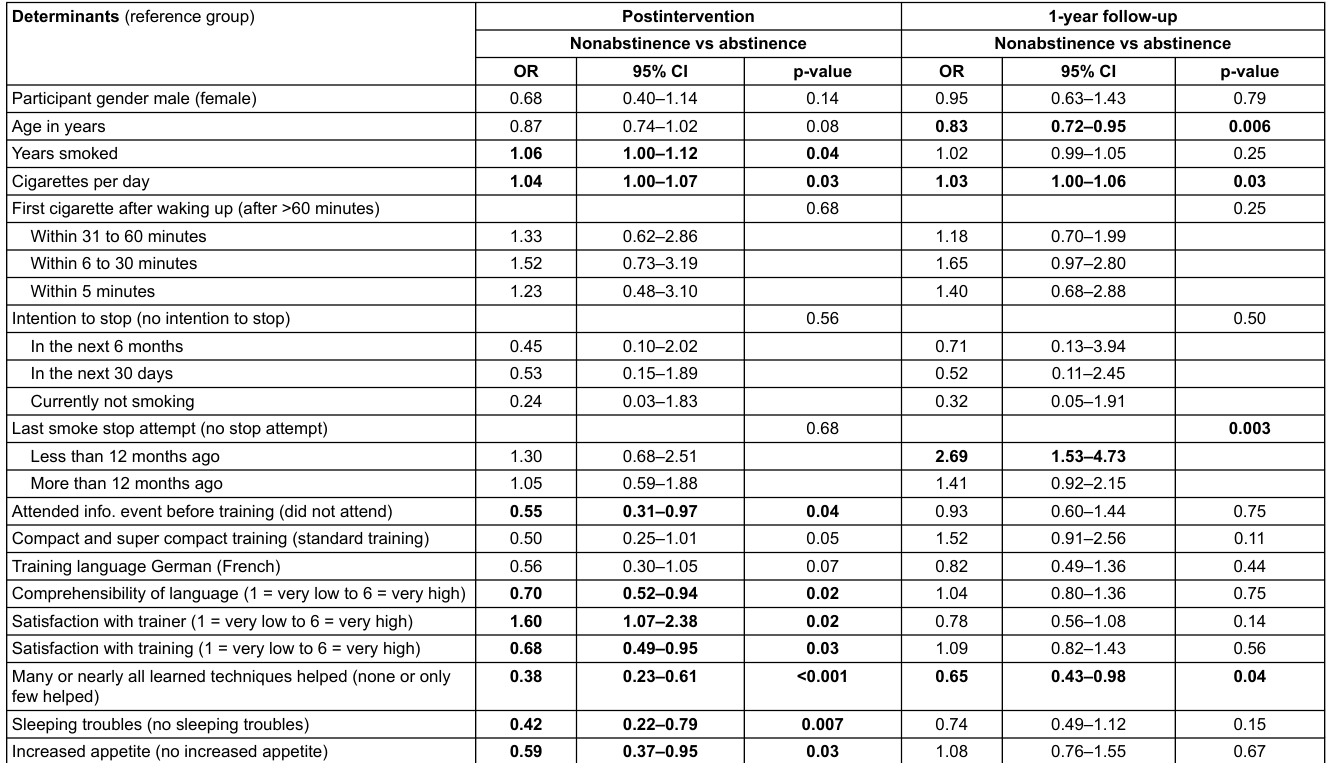
Table 4: Independent determinants of nonabstinence post-training and at 1-year follow-up.